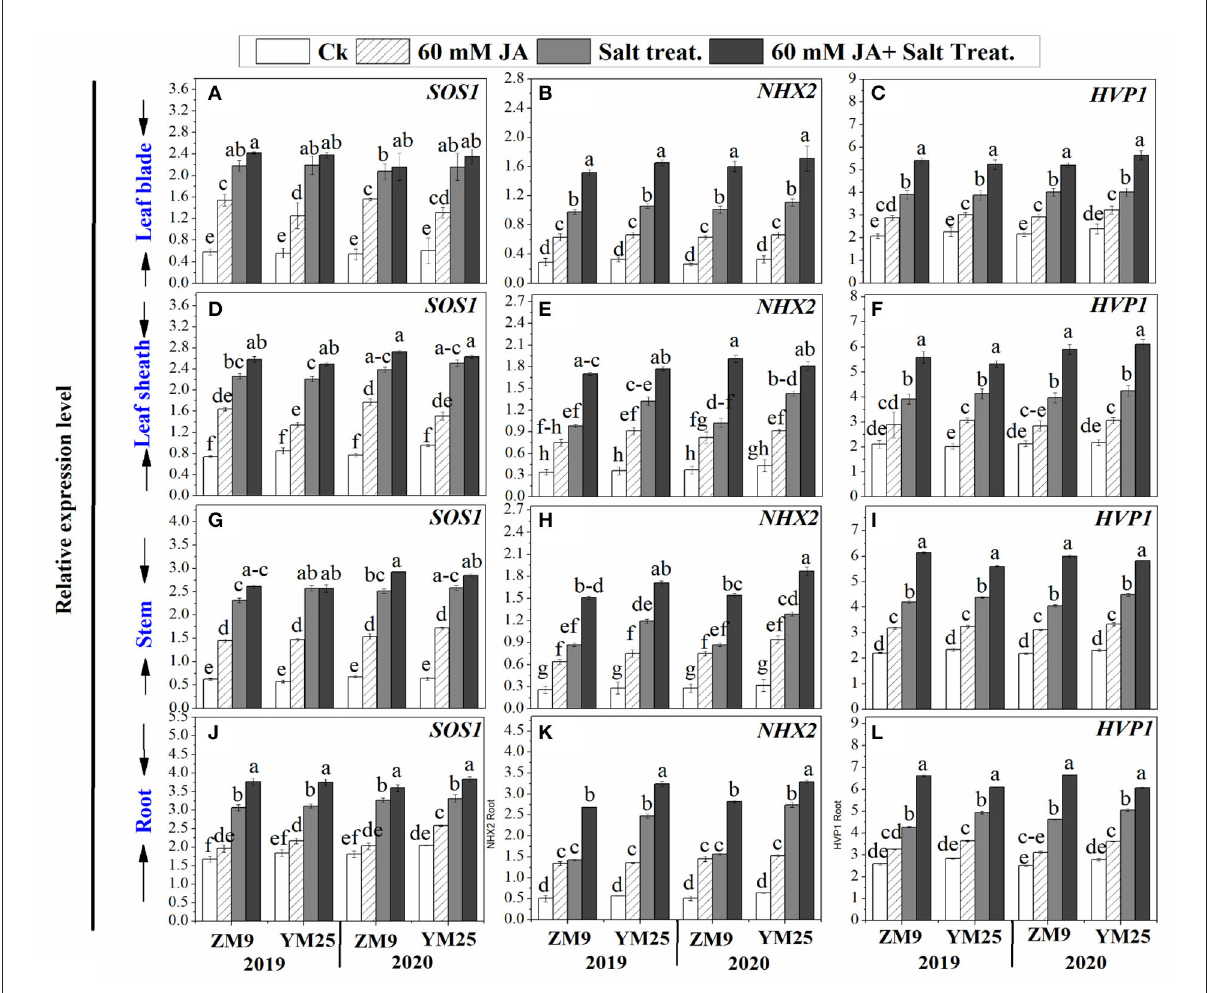
FIGURE5 Effects of JA priming on the relative expression of SOS1 , NHX2, and HVP1 in leaf blade [ (A–C) respectively], in leaf sheath [ (D–F) respectively], in stem [ (G–I) respectively], and in the root [ (J–L) respectively] of two wheat cultivars Mai9 (ZM9, salt-sensitive) and Yang Mai25 (YM25, salt-tolerant) under control and salinity stress conditions during two consecutive growing seasons 2019 and 2020. Means sharing the same letters, for a parameter during a year, do not differ significantly at P ≤ 0.05 among the studied factors. Ck, control; S, salt treatment; JA, jasmonic